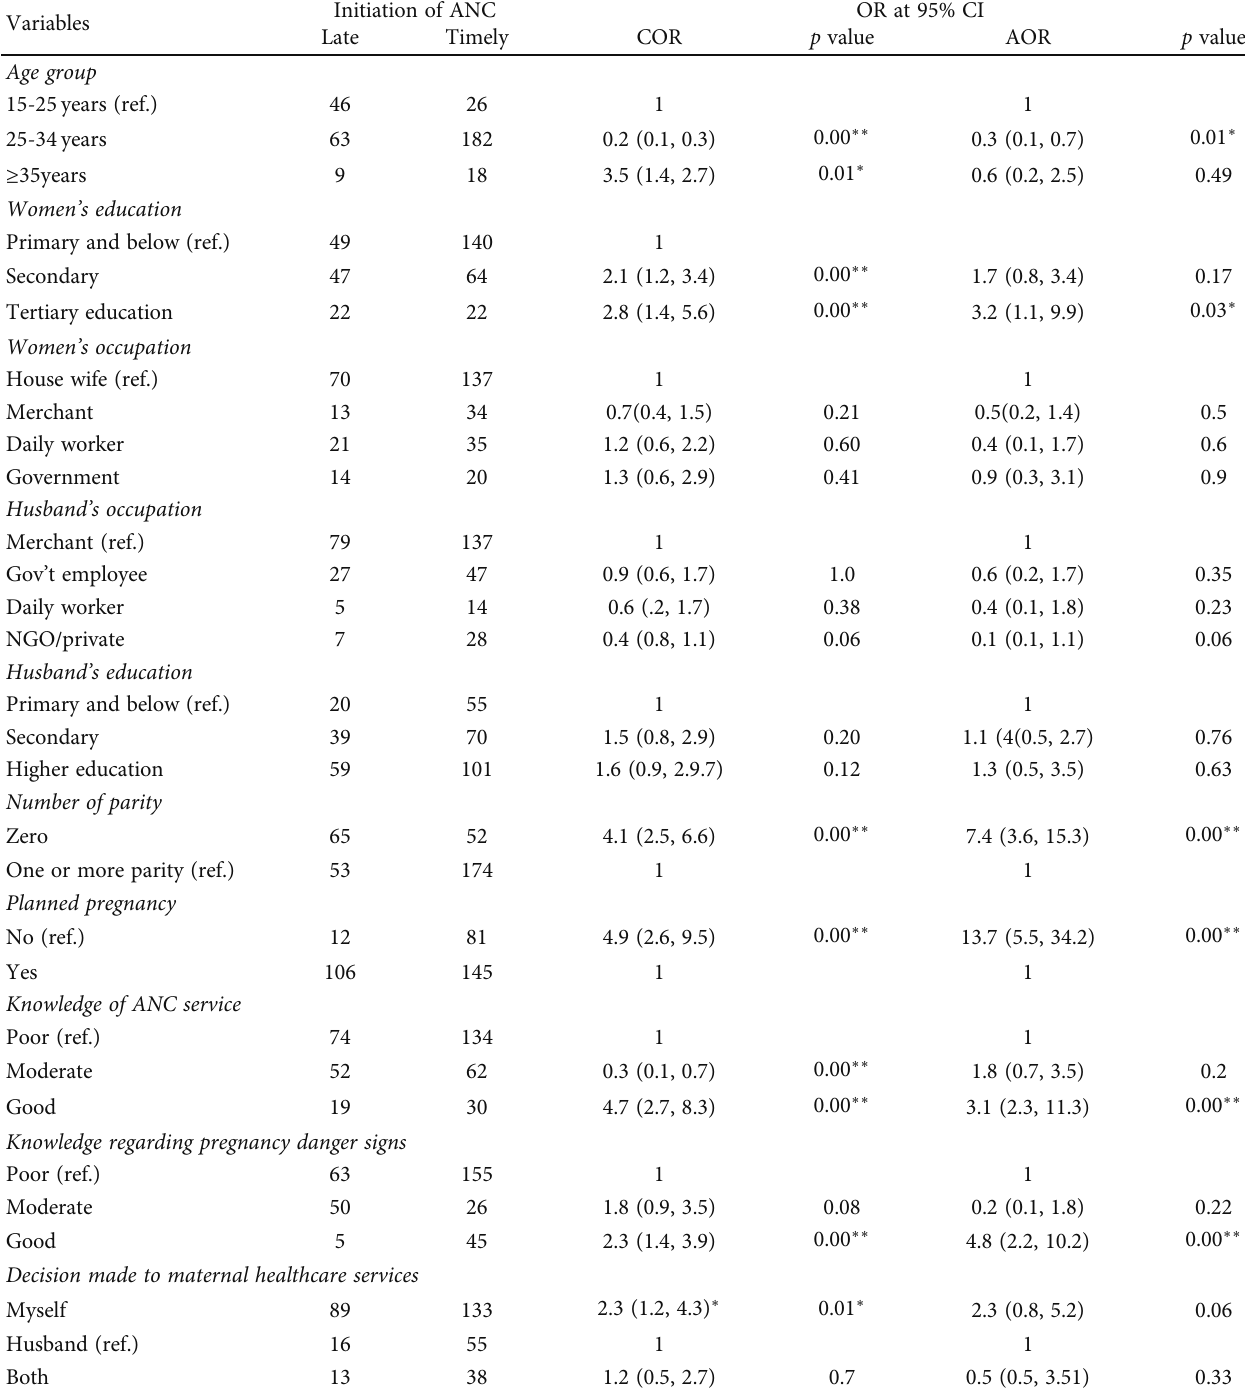
Table 3: Factors associated with timely initiation of ANC at Wachemo University Nigist Eleni Mohammed memorial comprehensive specialized hospital, Hossana, Ethiopia,